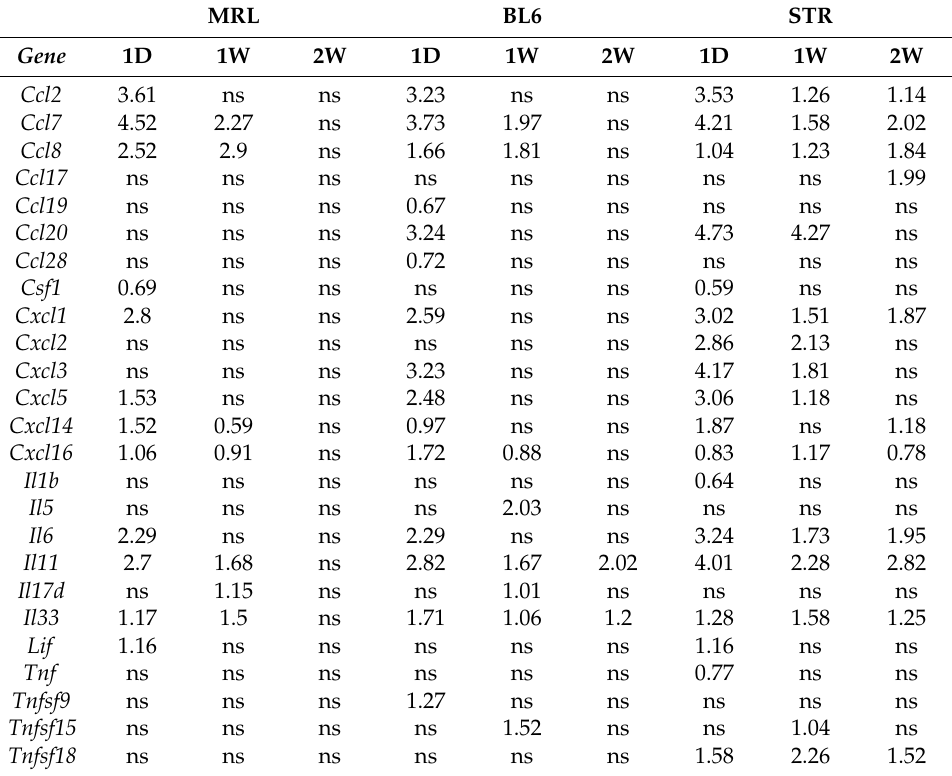
Table 1. Cytokines upregulated in knee joints after anterior cruciate ligament (ACL) injury. Fold upregulation (log2 scale) in injured joints compared to uninjured joints are shown in the table. ns: not significantly differentially